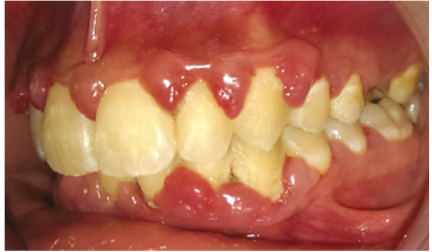
Figure 3: Baseline left side view.